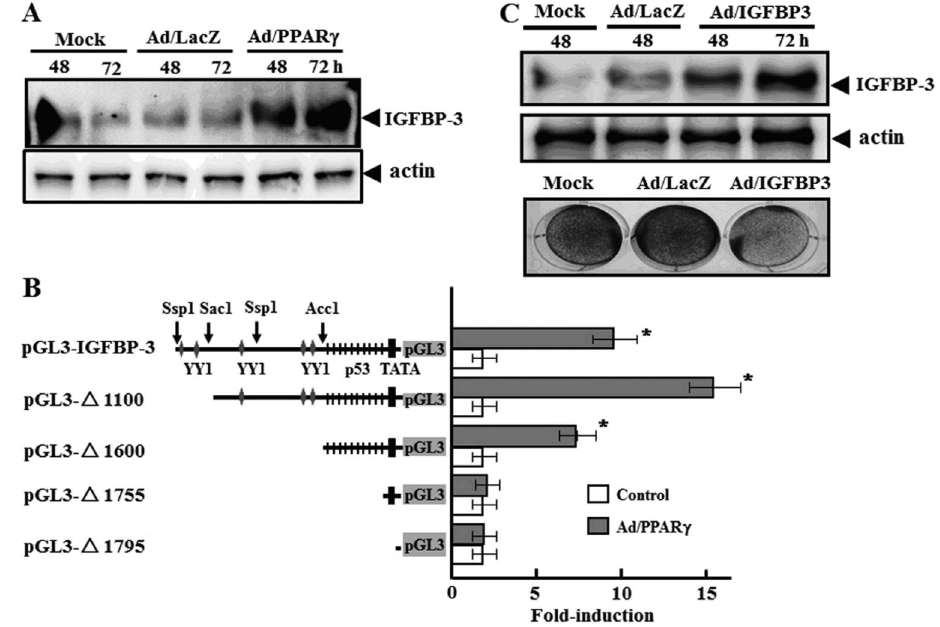
Figure 2. Effect of peroxisome proliferator activator receptor-gamma (PPAR c ) on insulin-like growth factor-binding protein-3 (IGFBP-3) expression and IGFBP-3 promoter activity. A , Western blot analysis of IGFBP-3 protein in SNU-668 cells infected with adenovirus- expressing (Ad)/PPAR c . B , Analysis of PPAR c -induced IGFBP-3 promoter activation. SNU-668 cells were transiently transfected with a luciferase reporter vector containing the full-length 1.9-kb IGFBP-3 promoter fragment or deletion variants of the IGFBP-3 promoter. After 24 h, cells were treated with Ad/PPAR c in serum-free media for 4 h. Luciferase activity was measured in cell lysates 48 h after Ad/PPAR c infection. Data are reported as the means of fold-increase in luciferase activity of Ad/PPAR c transfected cells relative to control cells not receiving Ad/PPAR c . *P , 0.05 compared to the Ad/LacZ-infected cells (Student’s t -test). C , Effect of IGFBP-3 overexpression, induced by Ad/IGFBP-3 infection, on the growth of SNU-668 cells. Upper panel , Western blot showing IGFBP-3 protein levels in mock-treated cells, Ad/LacZ-treated cells and cells treated with Ad/IGFBP-3. Lower panel , Crystal violet assay. Cell growth in mock-treated and Ad/LacZ-treated cells compared to cells treated with